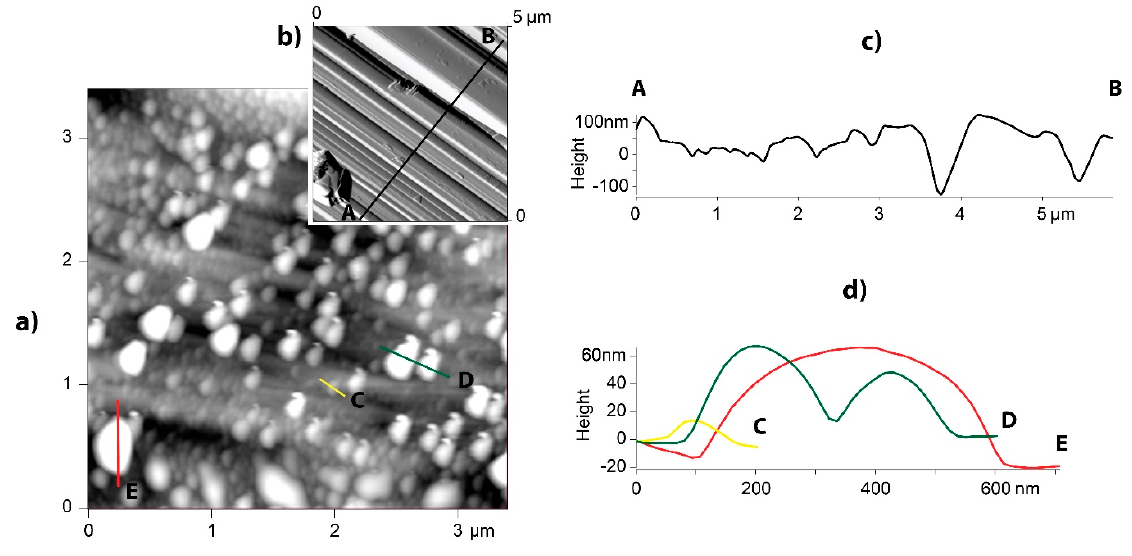
Figure 2. Atomic force microscope (AFM) images of offretite FF surface, in MilliQ water at 25 °C, at different magnifications: ( a ) height retrace image of particles of different sizes on surface and related sections ( d ); ( b ) amplitude retrace image of particularly clean surface terraces and related section ( c ). Erionite (MB2404)